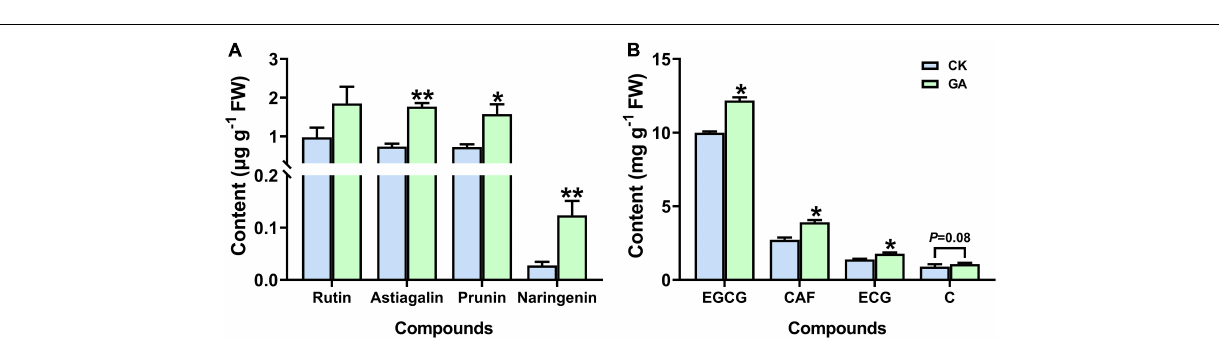
FIGURE 4 | GA treatment enhanced the accumulation of metabolites. (A) Flavonoids. (B) Caffeine and catechins. Data are presented as means + SE ( n = 3), and the asterisk indicates significant differences between GA-treated and control plant (* P < 0.05, ** P < 0.01, Student’s t